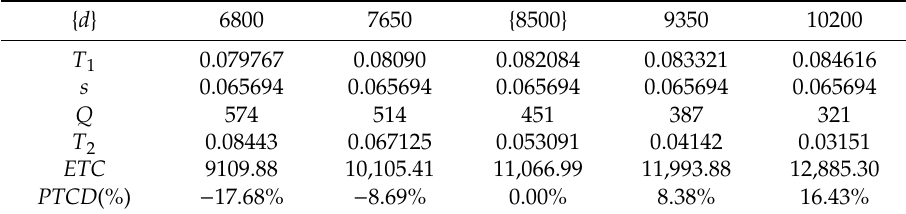
Table 8. Sensitivity analysis when the demand rate changes.